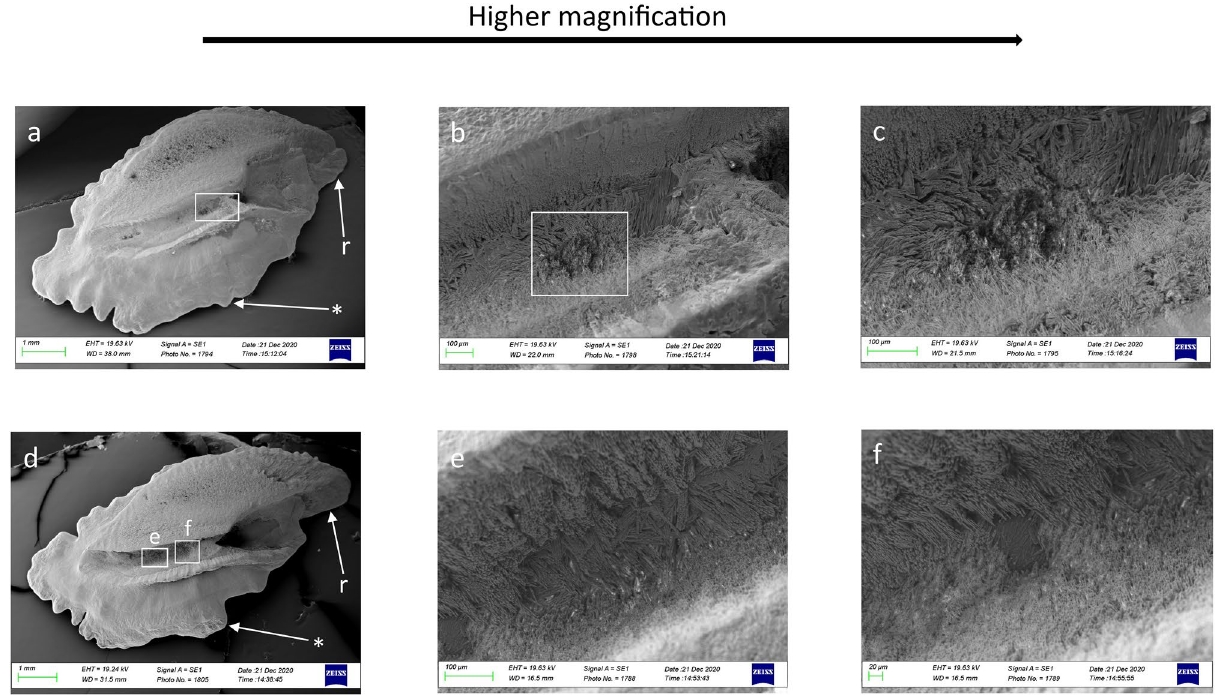
Figure 4. SEM images of the proximal surface of P. acarne : adult otoliths left sagitta ( a – d ), with details of sulcus acusticus ( b – e ), and external textural organization ( c – f ). (r) indicates the rostrum and (*) indicates the dorsal rim.